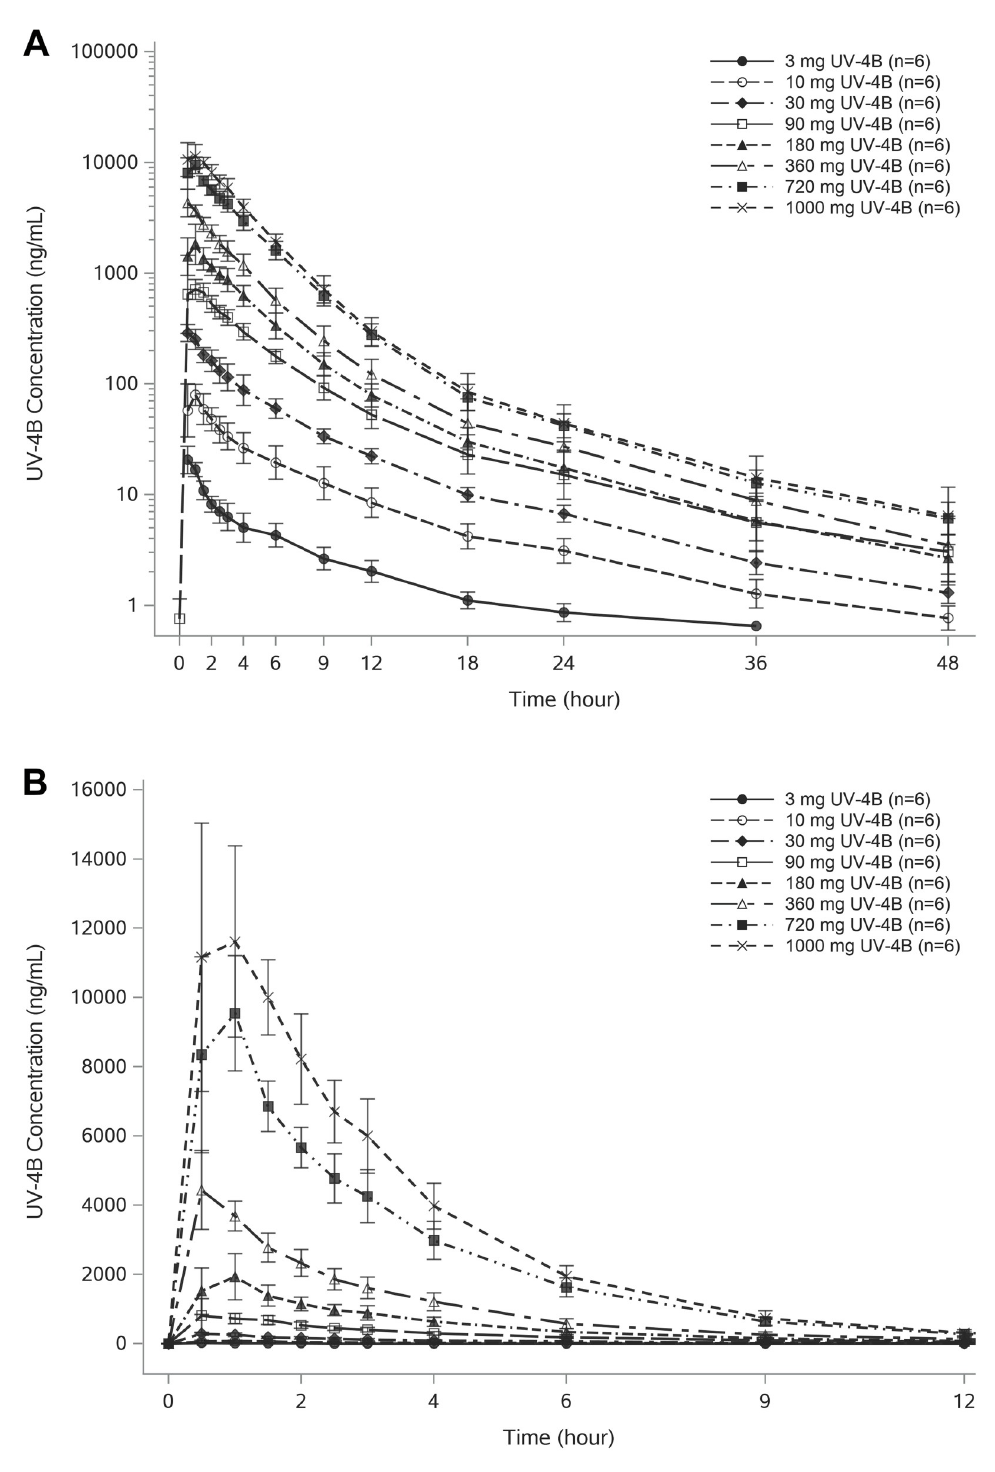
Fig 4. UV-4 plasma concentration-time profiles. A. Geometric mean ( ± SD) UV-4 concentration-time profiles are shown by UV-4 dose on semilogarithmic scale. Absorption was rapid (median T max of 0.5 to 1 hour) and dose independent. Maximum exposure increased approximately in proportion with dose. UV-4 concentrations were quantifiable over the entire 48-hour collection interval following administration of 10 mg or higher dose levels. Following administration of 3 mg